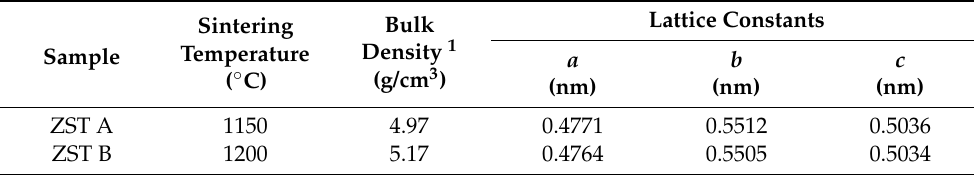
Table 1. The bulk density and lattice constants of ZST ceramics versus the sintering temperature.